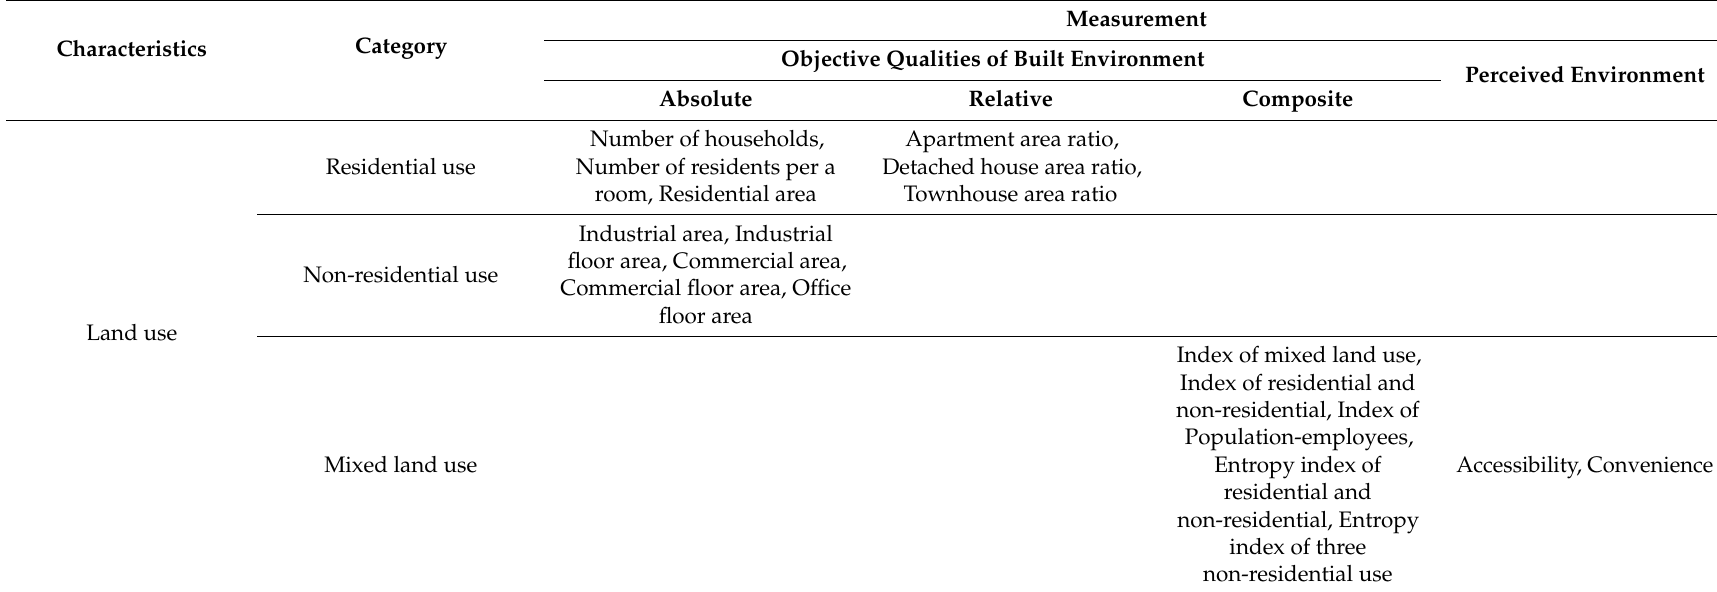
Table 1. Built environment characteristics and variables from the reviewed